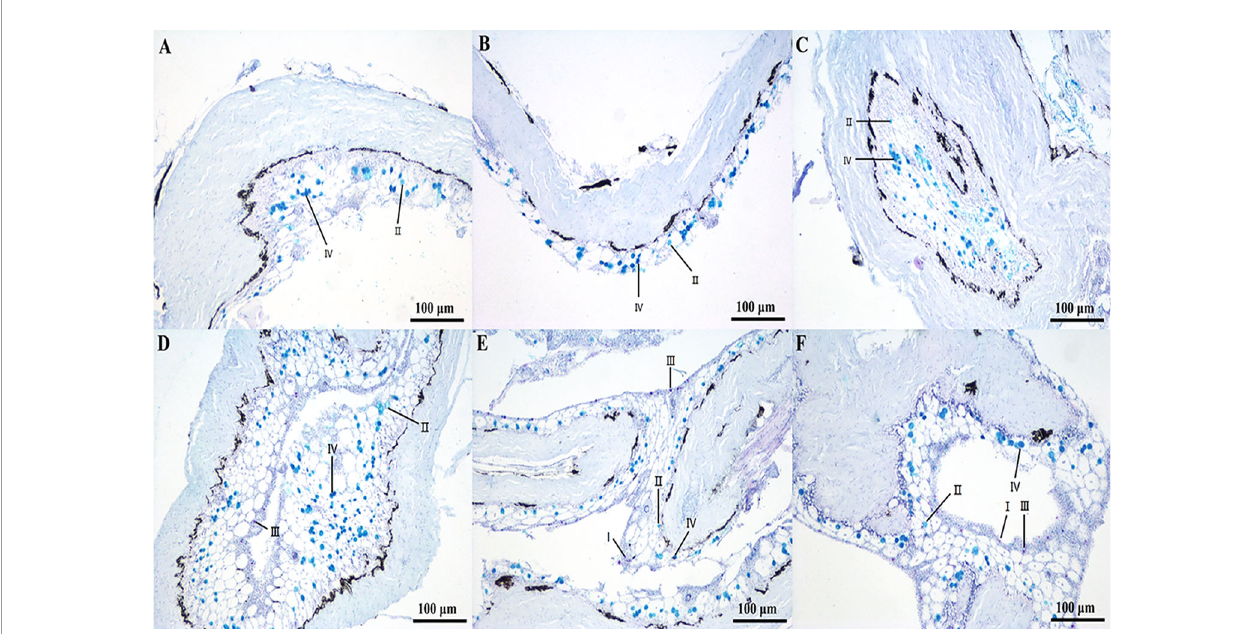
FIGURE 4 | Sections of skin/mucus from fi sh under transport stress. (A) Skin mucous cells of yellow cat fi sh in control group; (B) Skin mucous cells of yellow cat fi sh at 0 h transport; (C) Skin mucous cells of yellow cat fi sh at 2 h transport; (D) Skin mucous cells of yellow cat fi sh at 4 h transport; (E) Skin mucous cells of yellow cat fi sh at 8 h transport; (F) Skin mucous cells of yellow cat fi sh at 16 h transport.